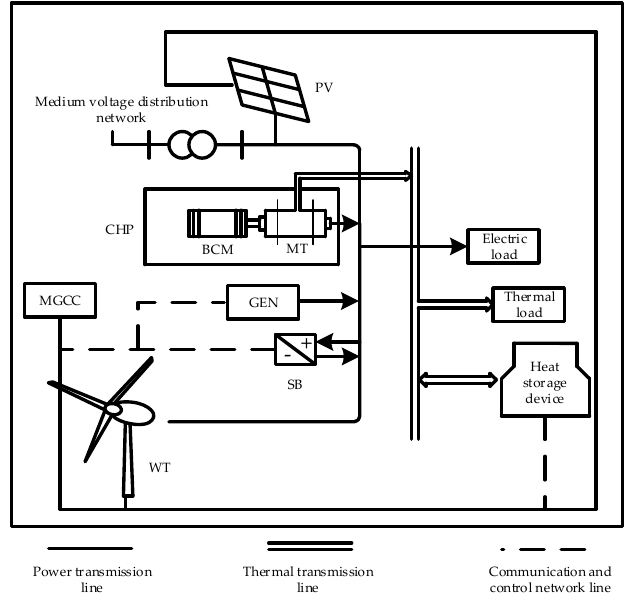
Figure 1. The structure of microgrid.